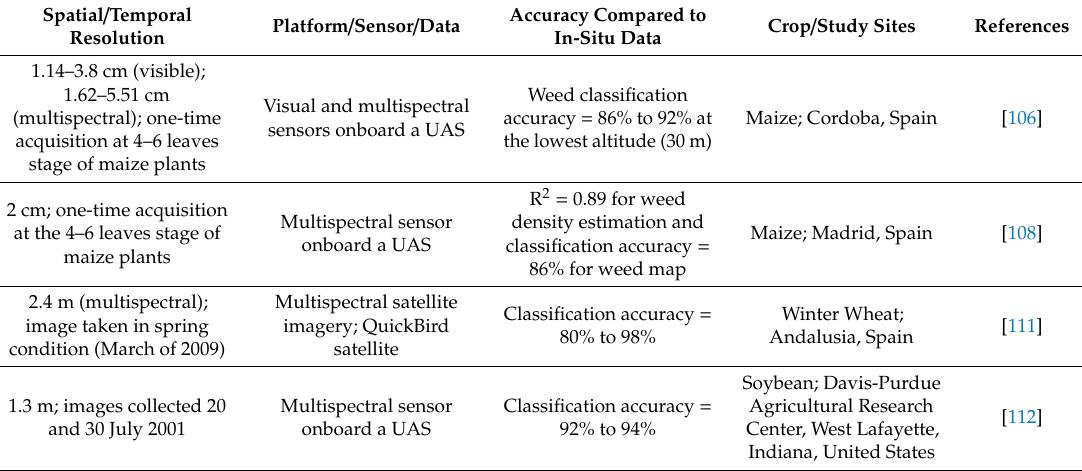
Table 8. Studies conducted for weed identification and classification using RS